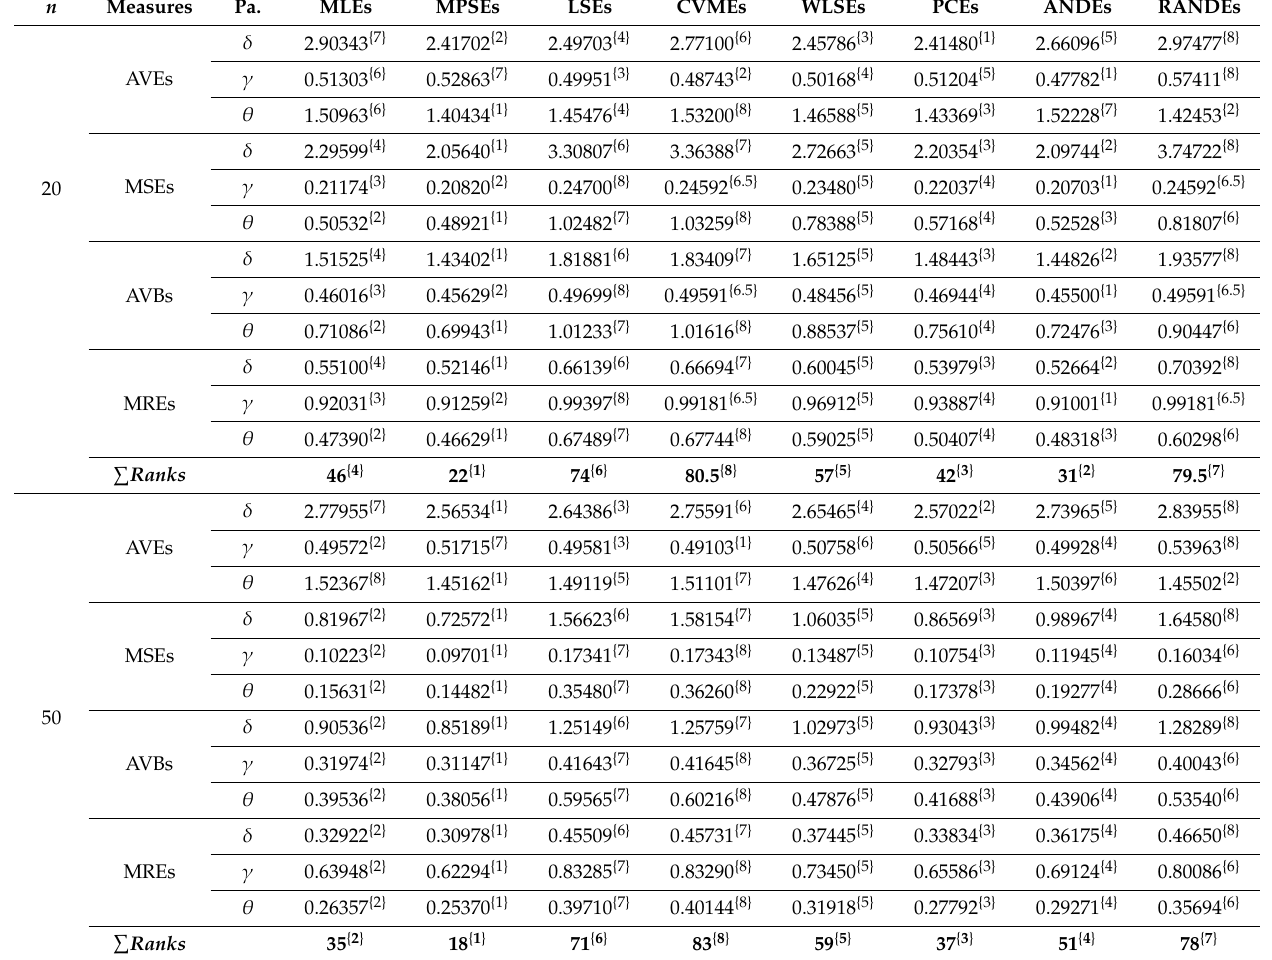
Table A5. Simulation results of several estimation methods for δ = 2.75, γ = 0.50 and θ =